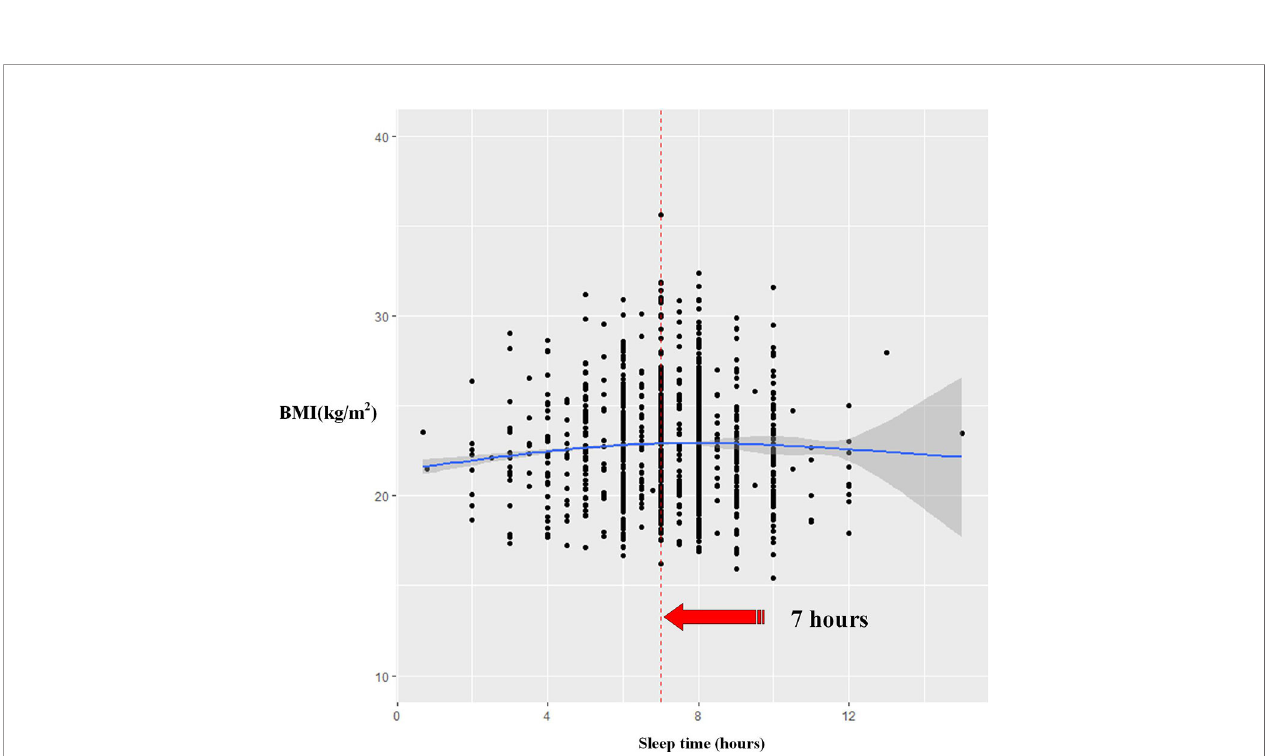
FIGURE 4 | The association between sleep duration and BMI among men using restricted cubic